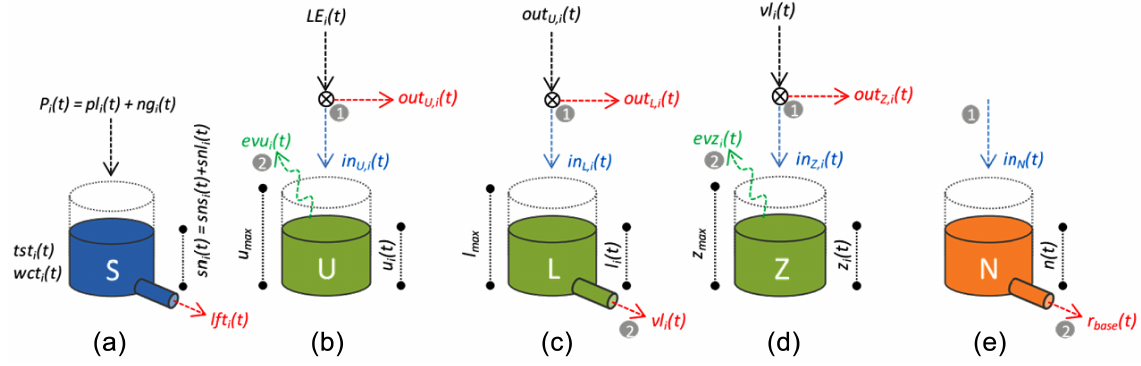
Figure A2. Schematic representation of MORDOR SD